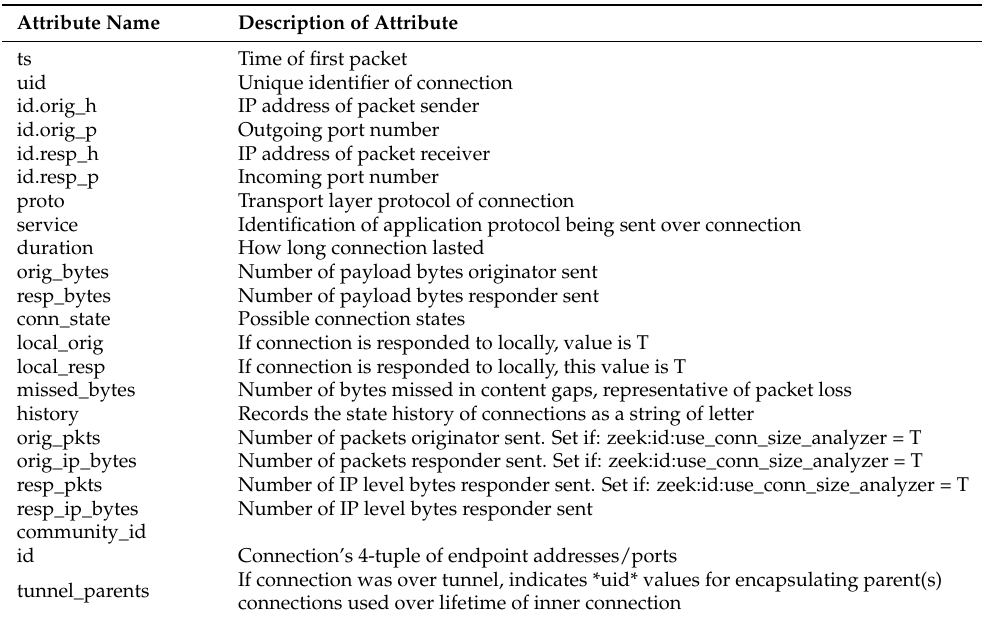
Table A1. Attributes of Zeek Conn Logs